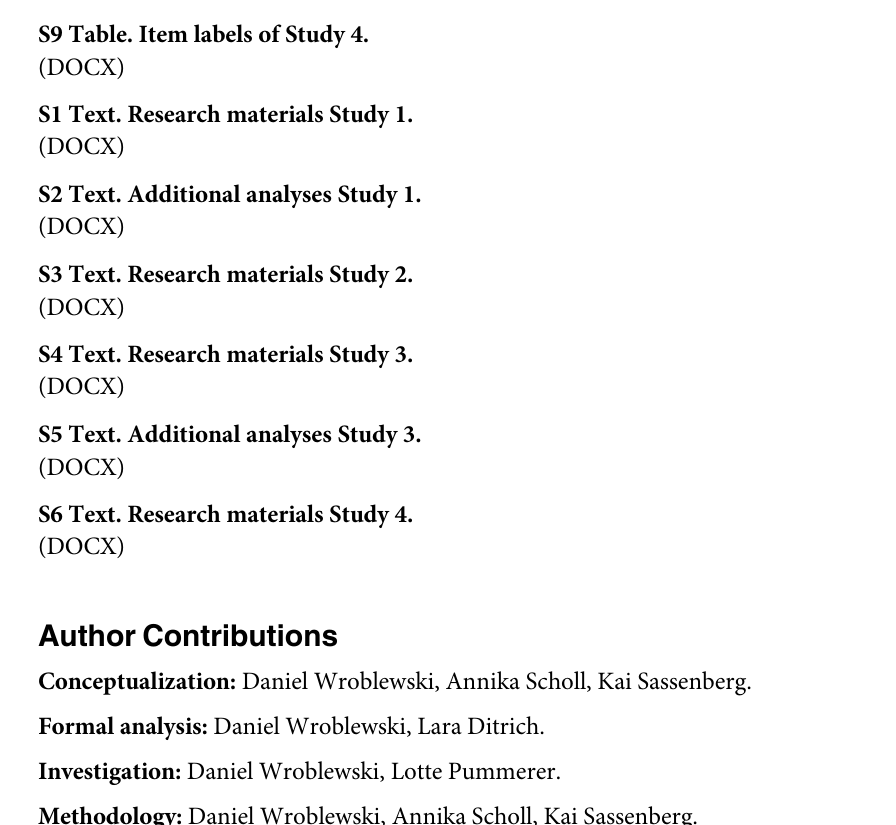
S9 Table. Item labels of Study